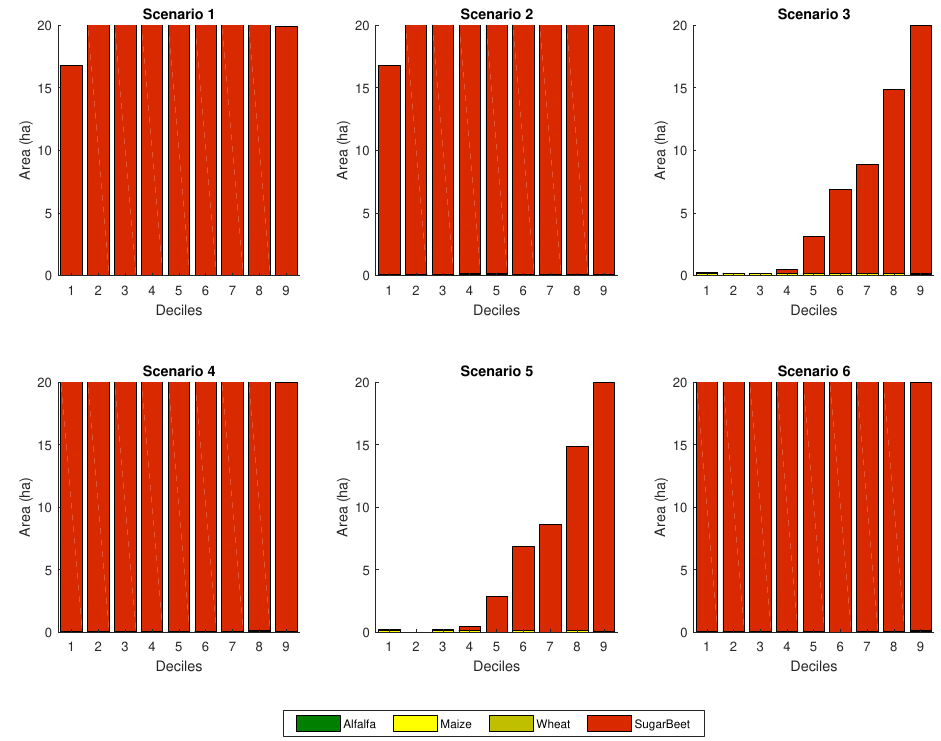
Figure 9. Crop allocation as a result of the optimisation processes for each decile of water supply and for each scenario at the situation